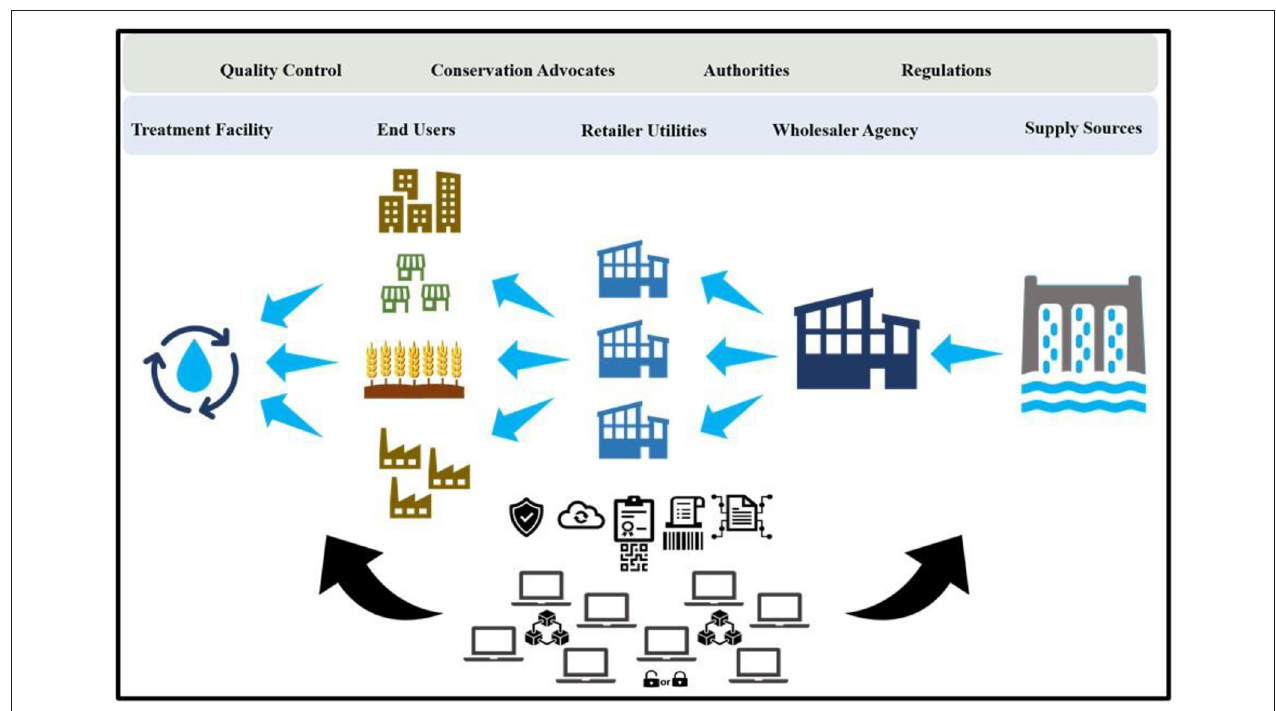
FIGURE 2 | Blockchain-based water management system. The graph is developed by authors using icons embedded in Microsoft Office